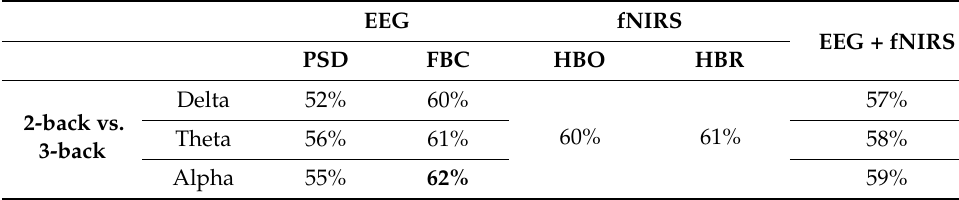
Table 4. SVM classification accuracy of 2-back vs. 3-back using different features.